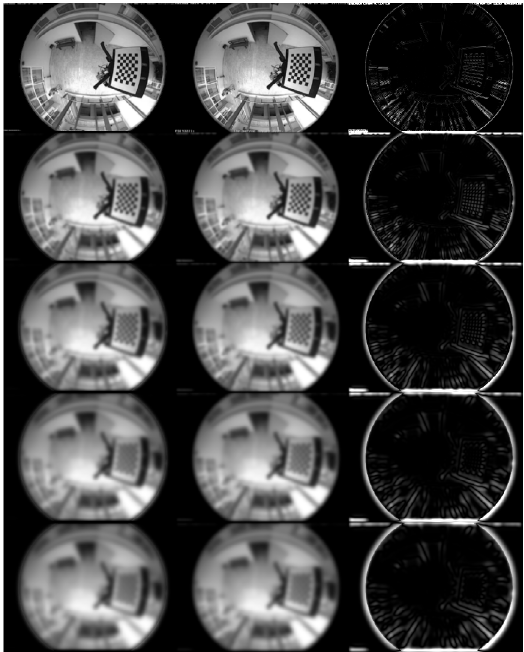
Figure 11. The results of Algorithm 1 for the geodetic Gaussian (left column) for the classic Gaussian (middle column and their absolute difference (appropriately scaled for visualization).